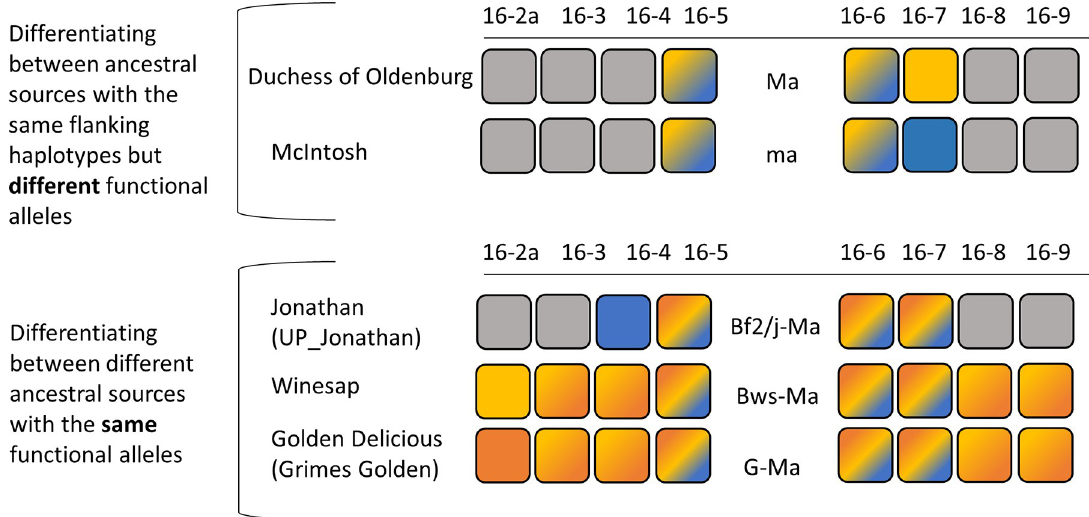
Fig 4. Example of cases with IBS between functional alleles and among ancestral sources. The first example compares a homolog of ‘McIntosh’ with that of ‘Duchess of Oldenburg’ inherited by ‘Honeycrisp’. In this case, the homologs share the same haplotype pattern in the haploblocks immediately flanking the locus (HBs 16–5 and 16–6) but were reported to be associated with different functional alleles ( Ma vs. ma ). To differentiate between the two functional alleles, haplotypes of adjacent haploblocks were needed from haploblocks 16–5 to 16–7, spanning a total of 1.8 cM across the locus. The second example compares the homolog of ‘Jonathan’ transmitted by its other parent than ‘Esopus Spitzenburg’, the homolog of ‘Winesap’ inherited by ‘Aurora Golden Gala’, ‘Delicious’, and ‘Splendour’, and the homolog of ‘Golden Delicious’ transmitted by ‘Grimes Golden’. In this example, all three have the same functional allele ( Ma ). However, to differentiate among the ancestral sources it was necessary to extend to adjacent haploblocks. The nearest haploblock was considered first and then the closest additional flanking haploblocks included one at a time either side of the locus until a unique extended patterns were identified. In this case, it was necessary to extend from haploblocks 16-2a to 16–9, spanning a total of 8.6 cM across the locus. Haplotypes shown with the gradient were those shared between individuals, while those in solid colors were those needed to be included to differentiate among ancestral sources that otherwise had the same immediate locus-flanking haplotypes but associated with different functional alleles or with different ancestral sources and the same functional